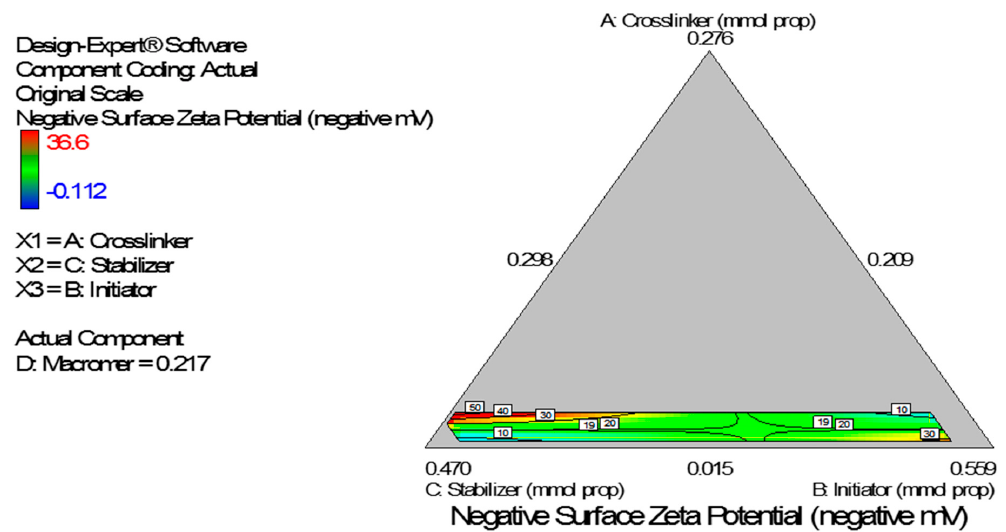
Figure 9. Model graph showing the design space and variation in negative zeta potential as a function of the mixture composition. A = Crosslinking agent; B = Initiators; C = Stabilizer and D = Macromonomer (poly- ε -caprolactone-based nanoparticles).